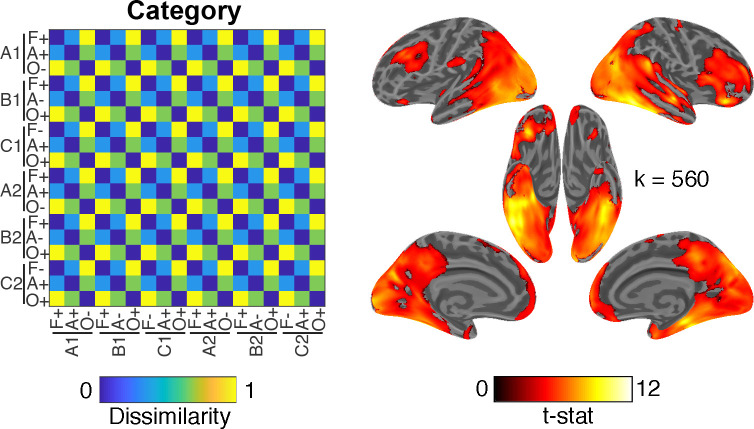
Whole brain searchlight analysis for image categories.Left panel shows hypothesis representational dissimilarity matrix for categories (based on animacy). Right panel shows the cluster corrected t-statistic map from a searchlight analysis projected onto an inflated cortical surface. This statistical map was thresholded with a cluster forming threshold of p<0.001 and corrected for multiple comparisons using cluster-based permutation tests at p<0.05. The cluster extent threshold from this test is given by value of k.